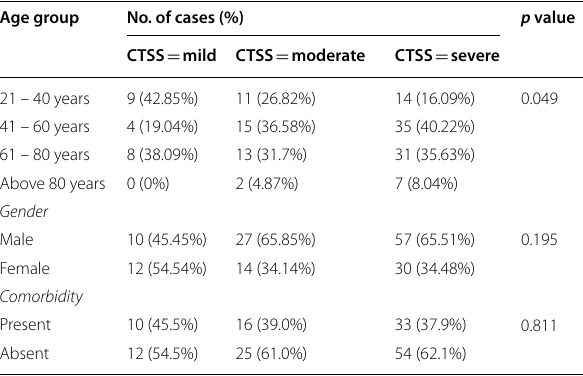
Table 4 Comparison of CT severity score according to demography and clinical parameters in all patients ( N